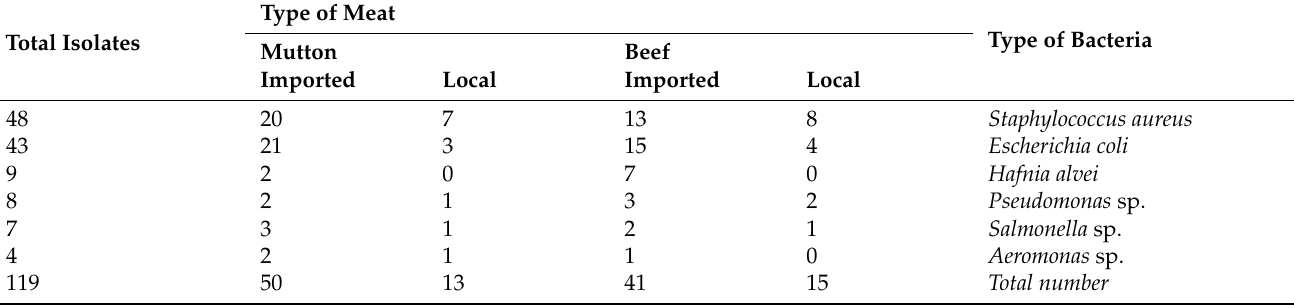
Table 2. Proportions of the bacteria isolated from local and imported chilled ground meat